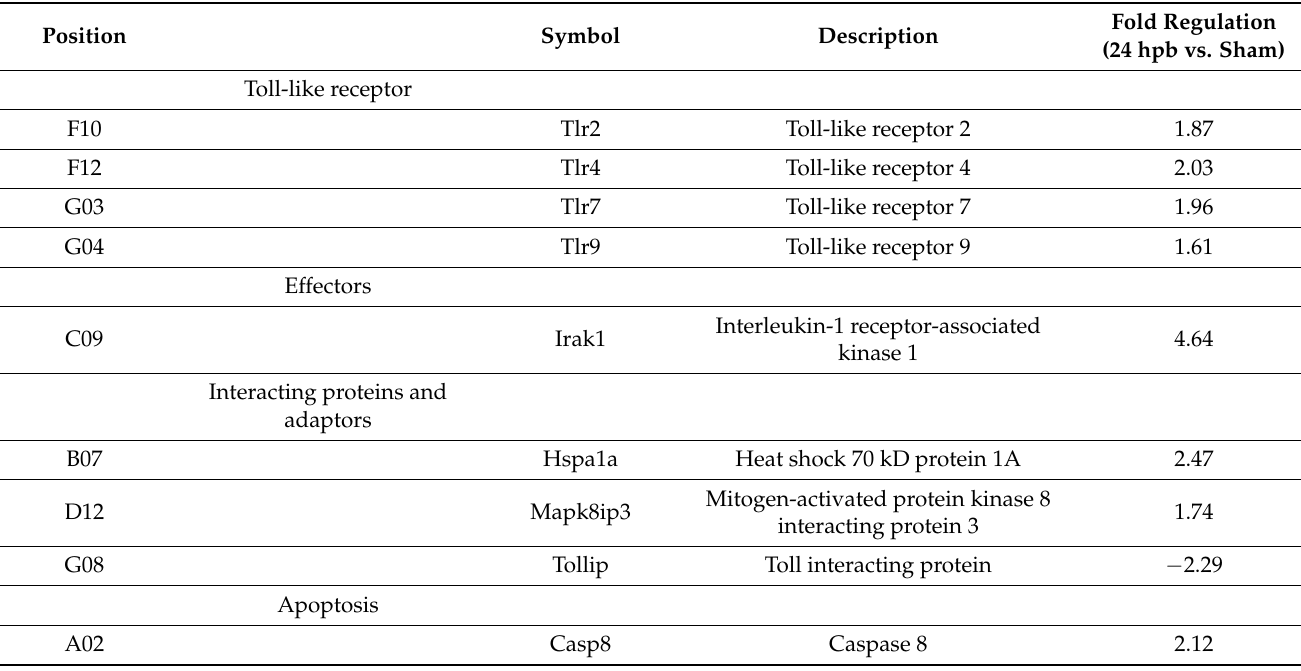
Table 3. List of DEGs of TLR-signaling pathways between burn-injury and sham